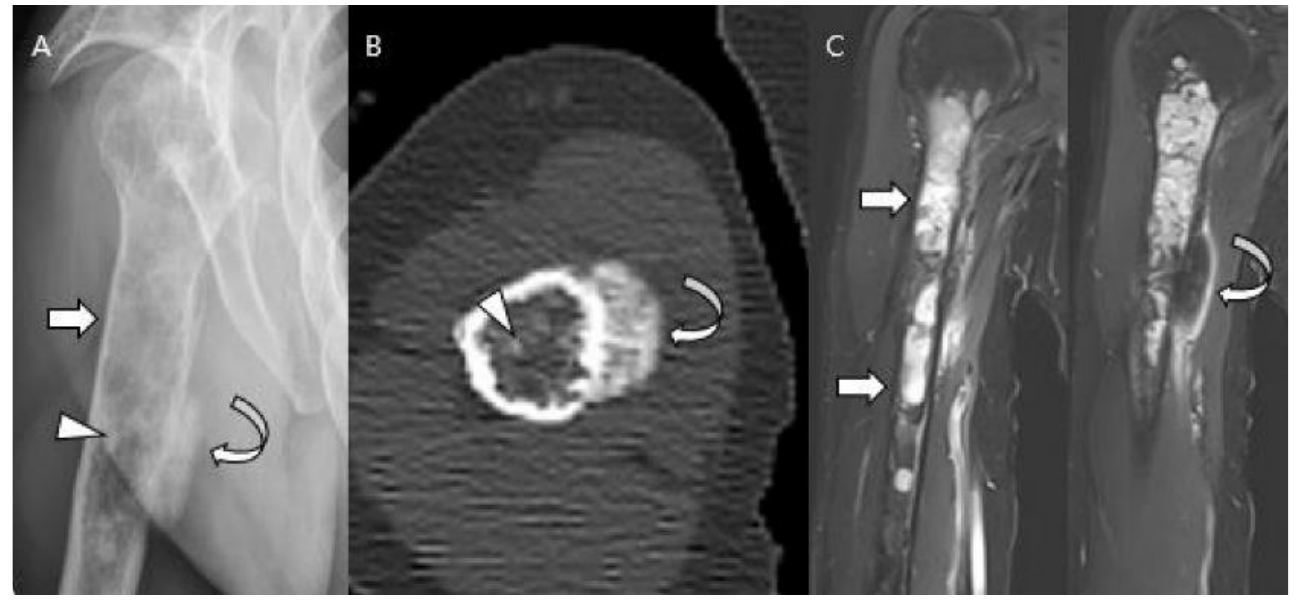
Figure 13. Dedifferentiated chondrosarcoma of the humerus in a 54-year-old man. ( A ) Plain radiograph shows an extensive mixed lytic and sclerotic lesion in the humerus with endosteal scalloping (arrow). Note the chondral-type mineralization in the intramedullary cavity (arrowhead) and the densely osteoid-type mineralization at the juxtacortical area (curved arrow). ( B ) Axial CT scan also reveals the intramedullary chondral-type (arrowhead) and the juxtacortical dense osteoid-type (curved arrow) mineralization. ( C ) Coronal T2-weighted images with fat suppression show high signal intramedullary lesion (arrows) with osteoblastic extraosseous extension (curved arrow), suggesting a dedifferentiated component of osteosarcoma.